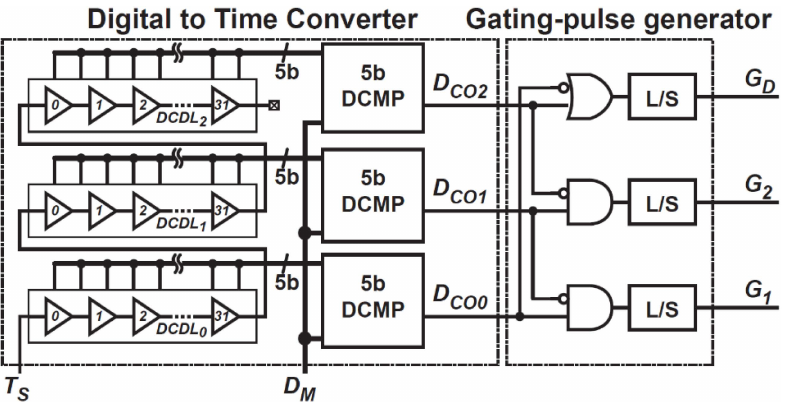
Figure 10. A circuit schematic of the digital-to-time converter and gating-pulse generator.